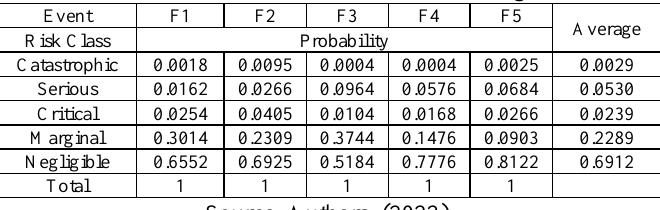
Table 3: Results of ETA for the five initiating